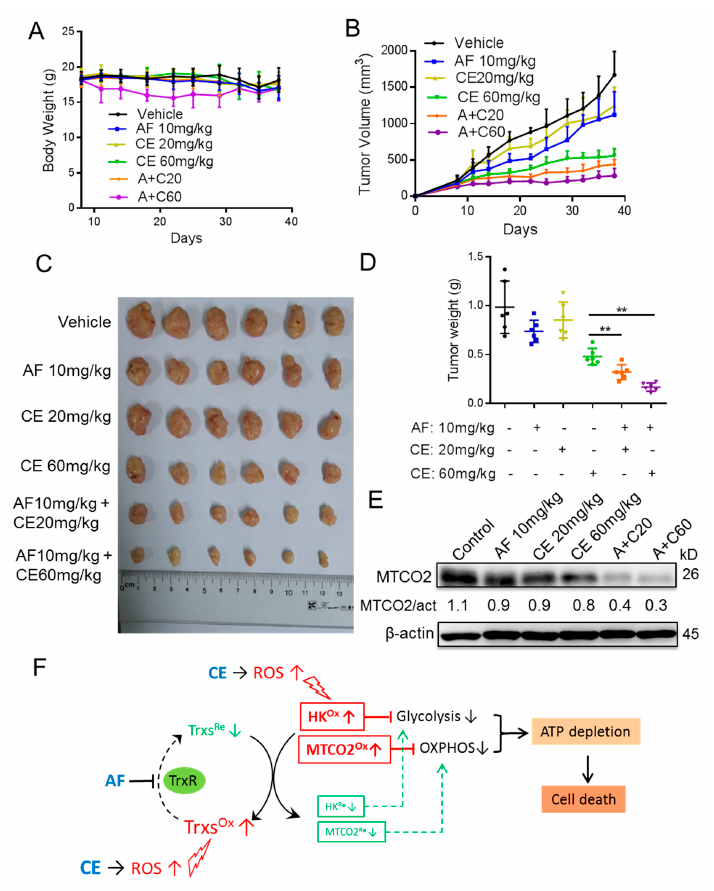
Figure 6. Effect of AF/CE combinational treatment in vivo. Athymic nude mice bearing DLD-1 xenografts were treated with the following drugs via oral injection (P.O.), with olive oil (vehicle), AF 10 mg/kg, CE 20 mg/kg, CE 60 mg/kg, AF 10 mg/kg + CE 20 mg/kg (A + C20), AF 10 mg/kg + CE 60 mg/kg (A + C60). Eight days after inoculation, tumor size and body weight of mice from each group (6 mice per group) were measured twice every week. ( A ) Body weight; ( B ) Tumor growth. Statistical significance of the differences in mean tumor volume between vehicle and indicated groups were analyzed by t -test, and all tests were two-sided. ( C ) Gross images and comparison of excised tumor size. ( D ) Tumor weights of different treatment groups at the end of animal experiment (38 days). ** p < 0.01 ( E ) MTCO2 protein levels in tumors excised from mice treated with the indicated conditions. ( F ) Schematic model explaining the AF/CE combinational therapy. CE induced ROS increase, which in turn causes oxidation of proteins (Trxs, HK and MTCO2). AF inhibits TrxR, and thus keeps Trxs in oxidized form, which cannot reduce/repair the oxidized proteins (HK, MTCO2) leading to inhibition of both glycolysis and mitorespiration, ATP depletion, and cell death.